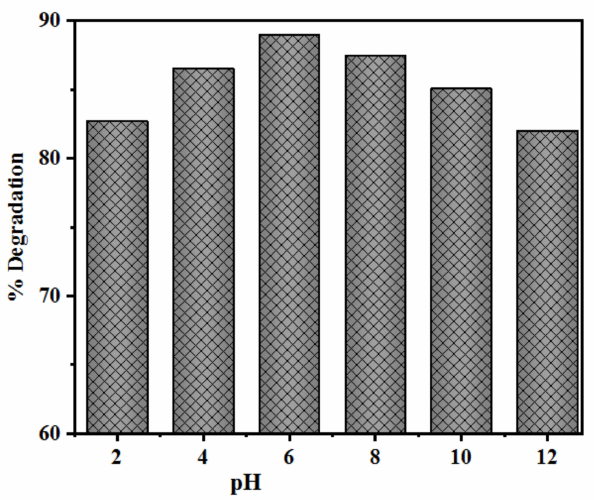
Figure 14. Influence of varying pH values on sonophotocatalytic degradation of SDB in the presence of Mn 2+ :ZnS Qds at optimum conditions (15 mL of SDB 70 ppm, 75 min irradiation, 40 mg